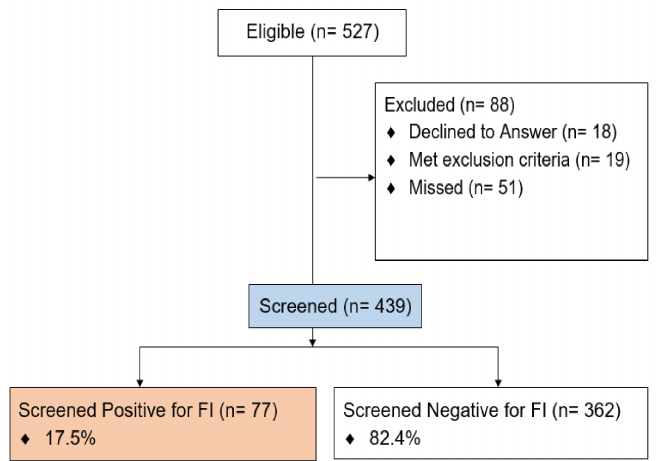
Figure. Study flow chart of patients screened using the Hunger Vital Screening Tool for food insecurity. FI, food insecurity.